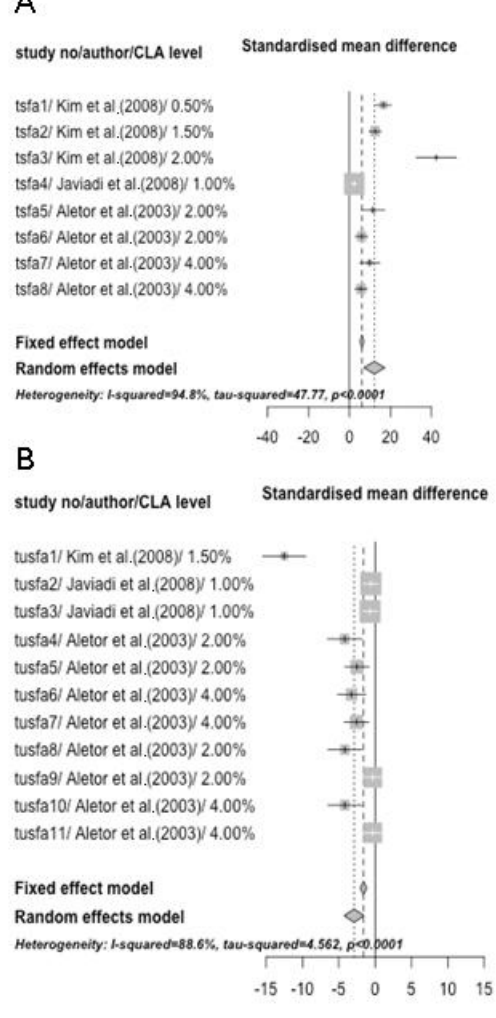
Figure 2. Forest plots for the effect of CLA feeding on total saturated fatty acid (A) and unsaturated fatty acid (B) in thigh meat of broiler